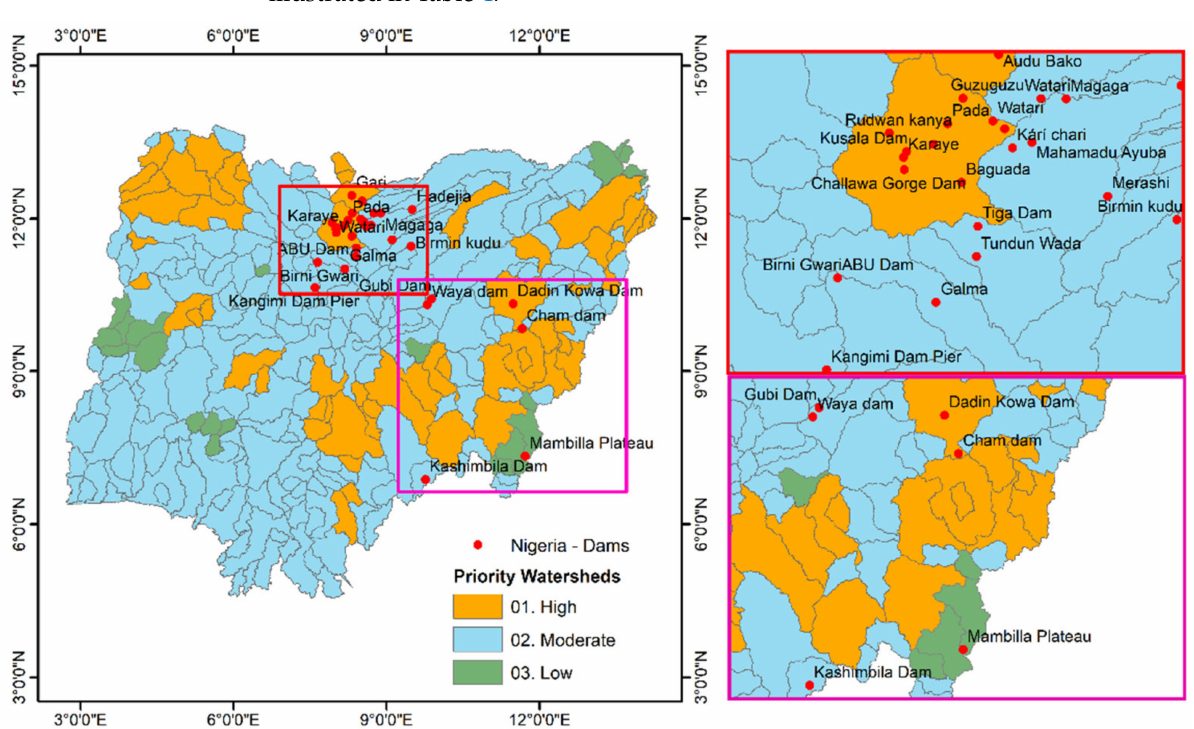
Figure 11. Map showing the location of dams in